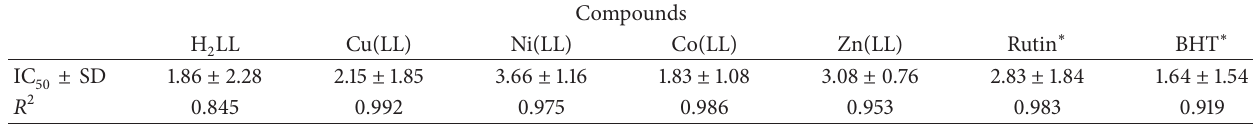
LL Schiff bases and their metal complexes. 2